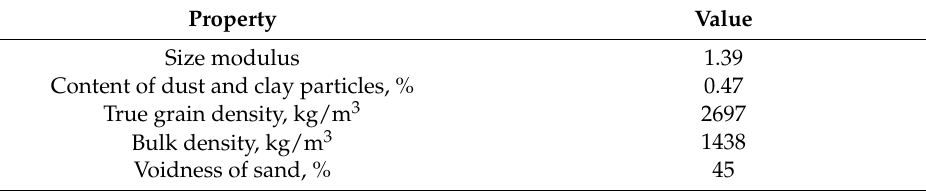
Table 3. Physical characteristics of sand.